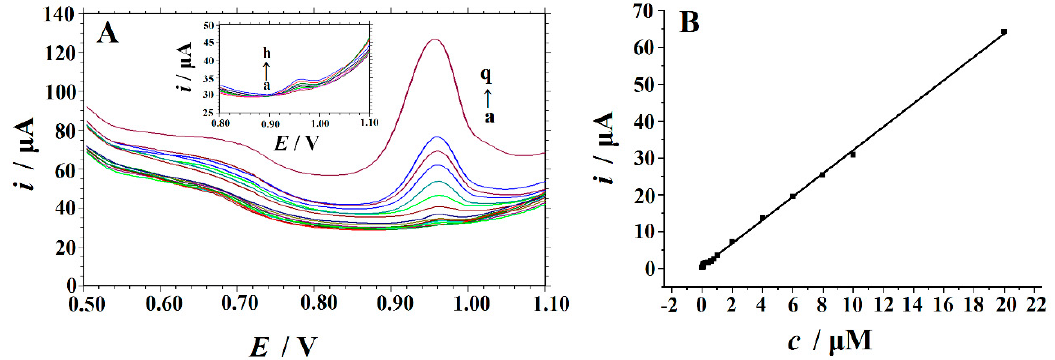
Figure 9. ( A ) SWVs of different concentrations of Trp (a → q: 0.02, 0.04, 0.06, 0.08, 0.1, 0.2, 0.4, 0.6, 0.8, 1.0, 2.0, 4.0, 6.0, 8.0, 10, and 20 µ M) on the Cu 2 O–ERGO / GCE in 0.05 M H 2 SO 4 solution at a scan rate of 100 mV s − 1 . Inset: magnified image of the curve a → h. ( B ) The linear relationship between the i p and Trp concentration in the range of 0.02–20 µ M. Accumulation potential: –0.1 V; accumulation time: 120 s.